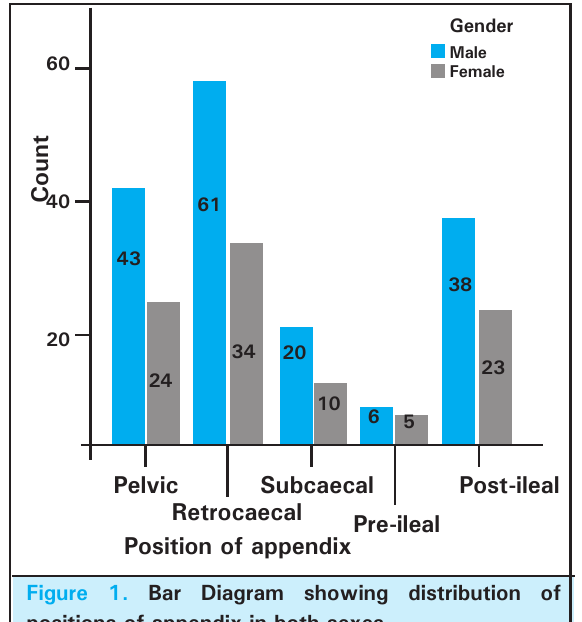
Figure 1. Bar Diagram showing distribution of positions of appendix in both